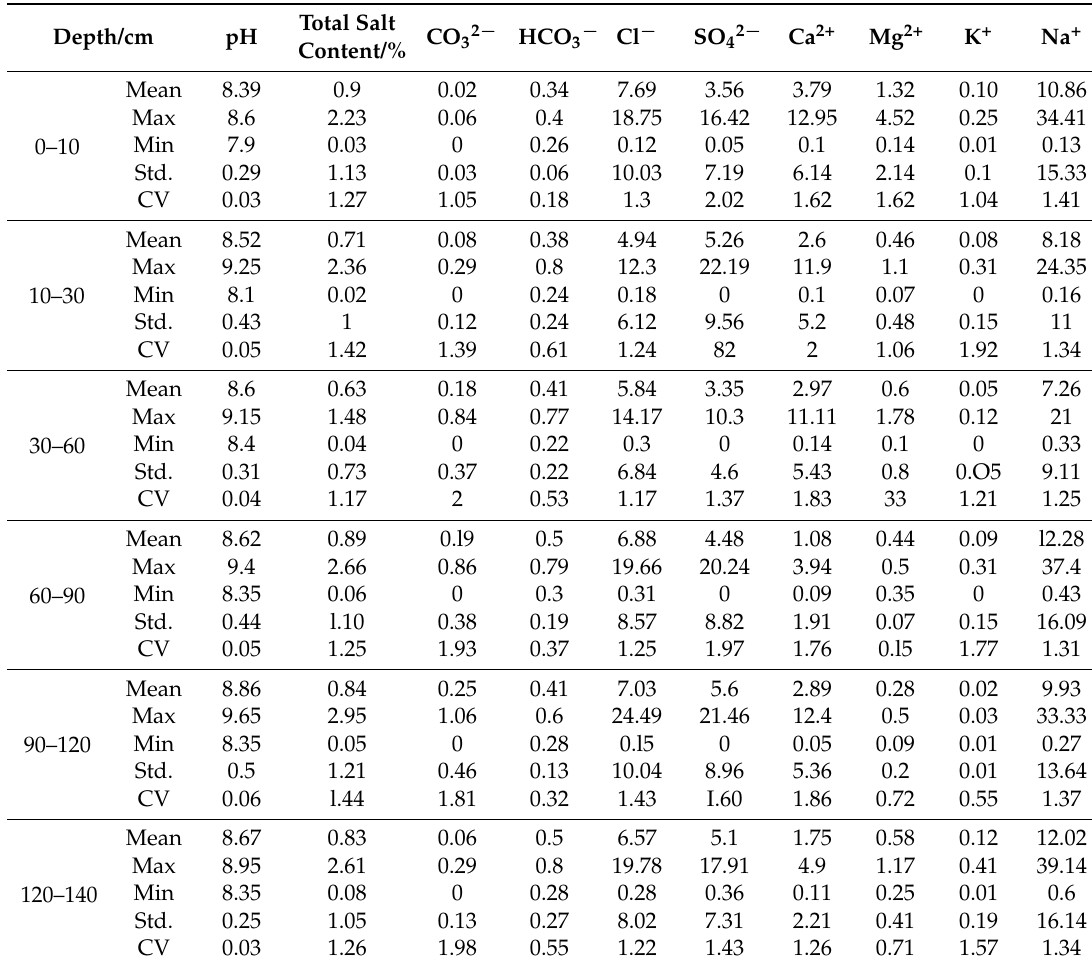
Table 3. Statistical characteristics of soil salinity at different